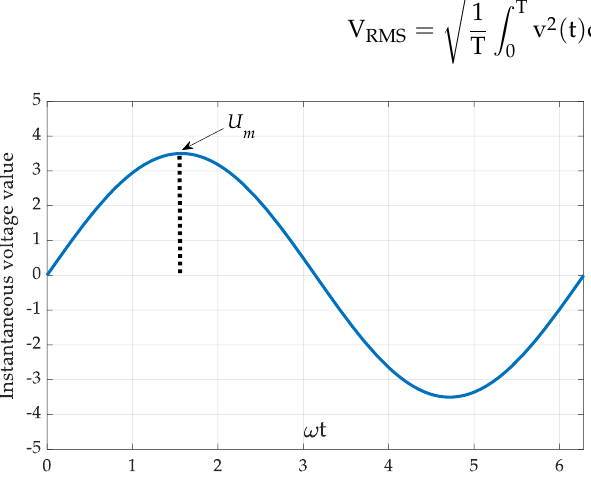
Figure 1. Instantaneous AC voltage curve.